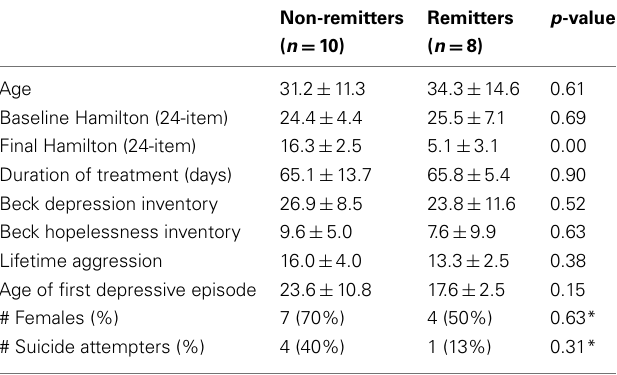
Table 1 | Subject clinical and demographic